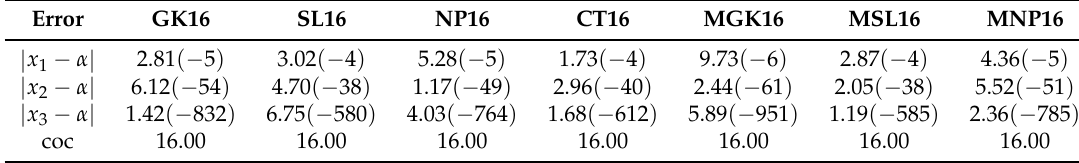
Table 3. Numerical results for f 1 , x 0 =